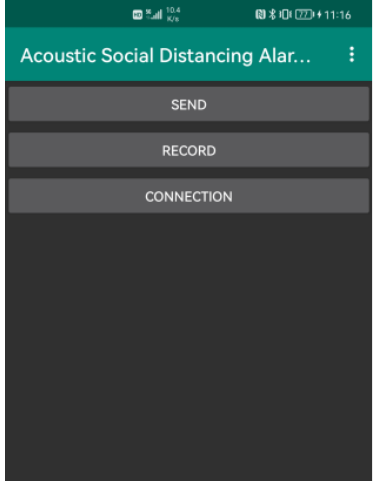
Figure 20. Mobile phone test software interface.